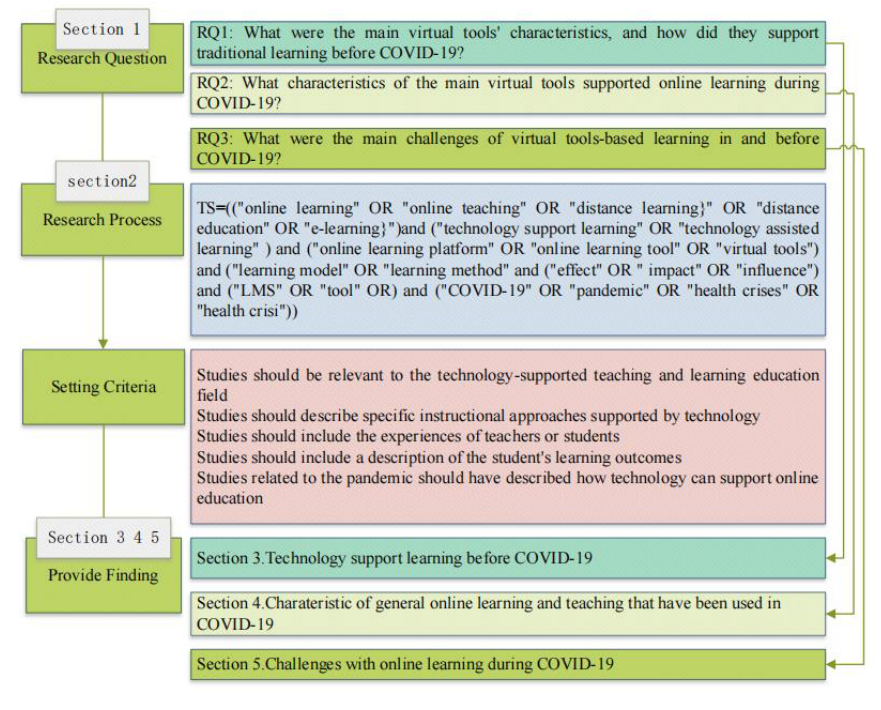
Figure 2. Critical steps of this review. Table 2. The specific criteria of inclusion and exclusion.